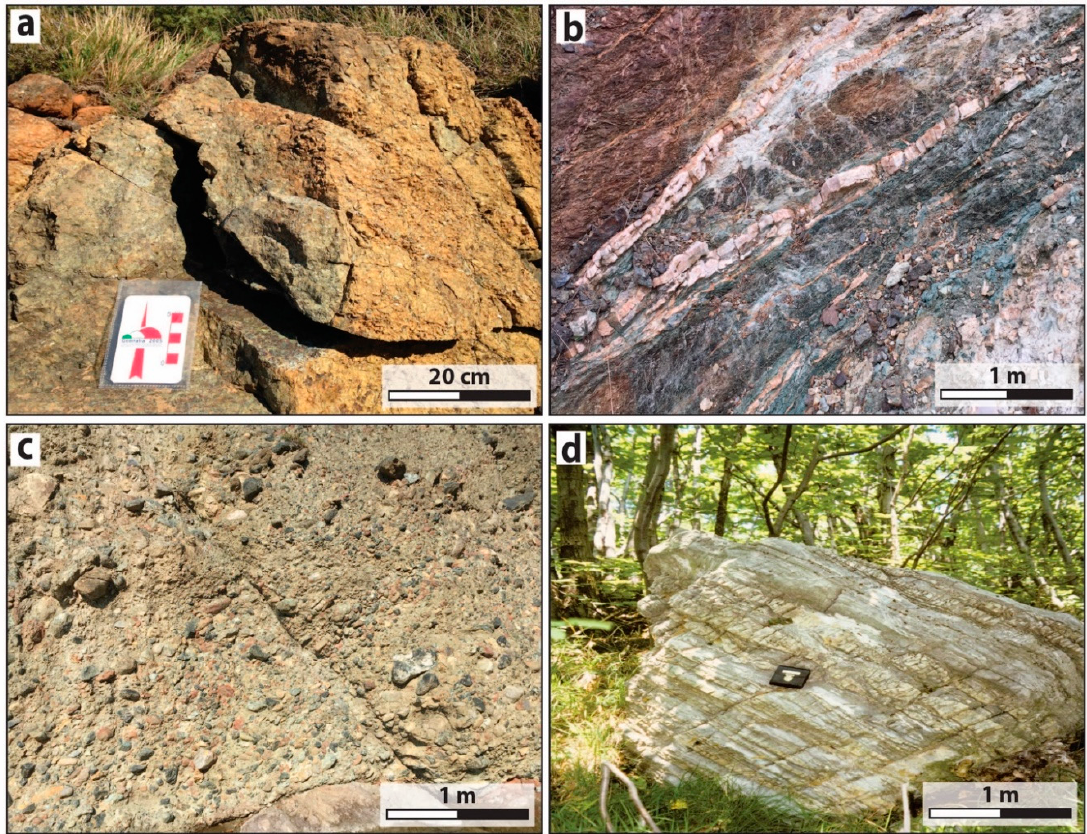
Figure 3. (Color online): Geodiversity of the area: ( a ) lherzolites; ( b ) listvenites; ( c ) conglomerate belonging to the “Conglomerati di Molare” (Tertiary Piedmont Basin); and ( d ) carbonates related to the “Calcari di Gallaneto”.